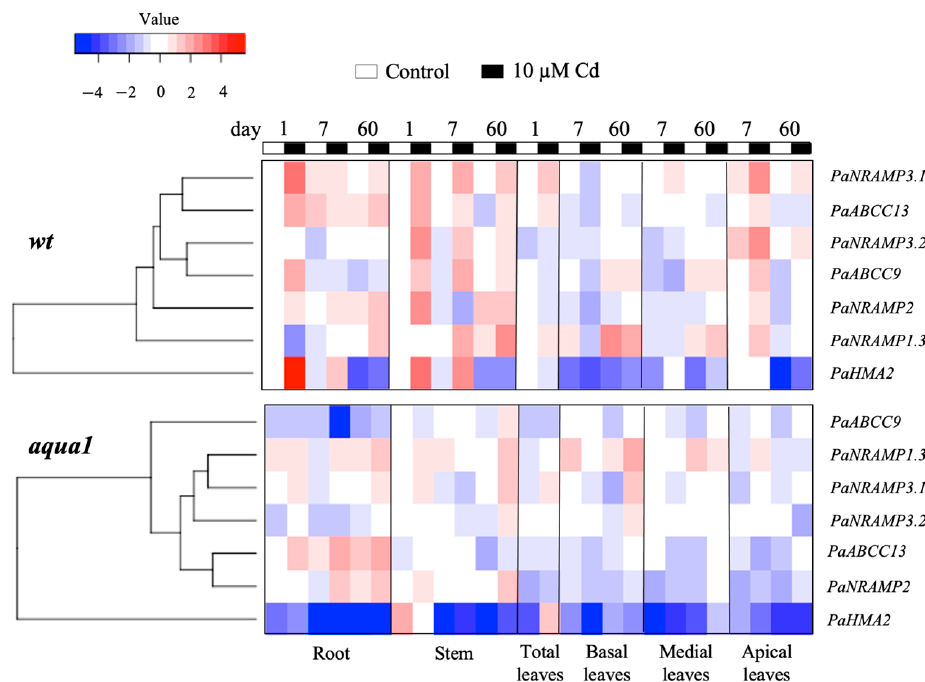
Figure 3. Heat maps of gene transcription levels in wt and aqua1 plants at 1, 7, and 60 d in control and treated (10 µ M Cd) conditions. Data displayed in the heat map are expressed in ln2 − ∆∆ Ct . At 1 d of Cd treatment, PaHMA2 was strongly up-regulated in root and stem of wt plants (Figure 4). In aqua1 plants PaHMA2 was slightly up-regulated in roots and, in particular, in leaves. At 7 d, this gene was up-regulated in stem and medial leaves of wt treated plants and up-regulated in apical leaves of both lines. At 60 d of Cd exposure, PaHMA2 remained up-regulated only in medial leaves of both lines while its transcription was strongly suppressed in the other plant parts (Figure